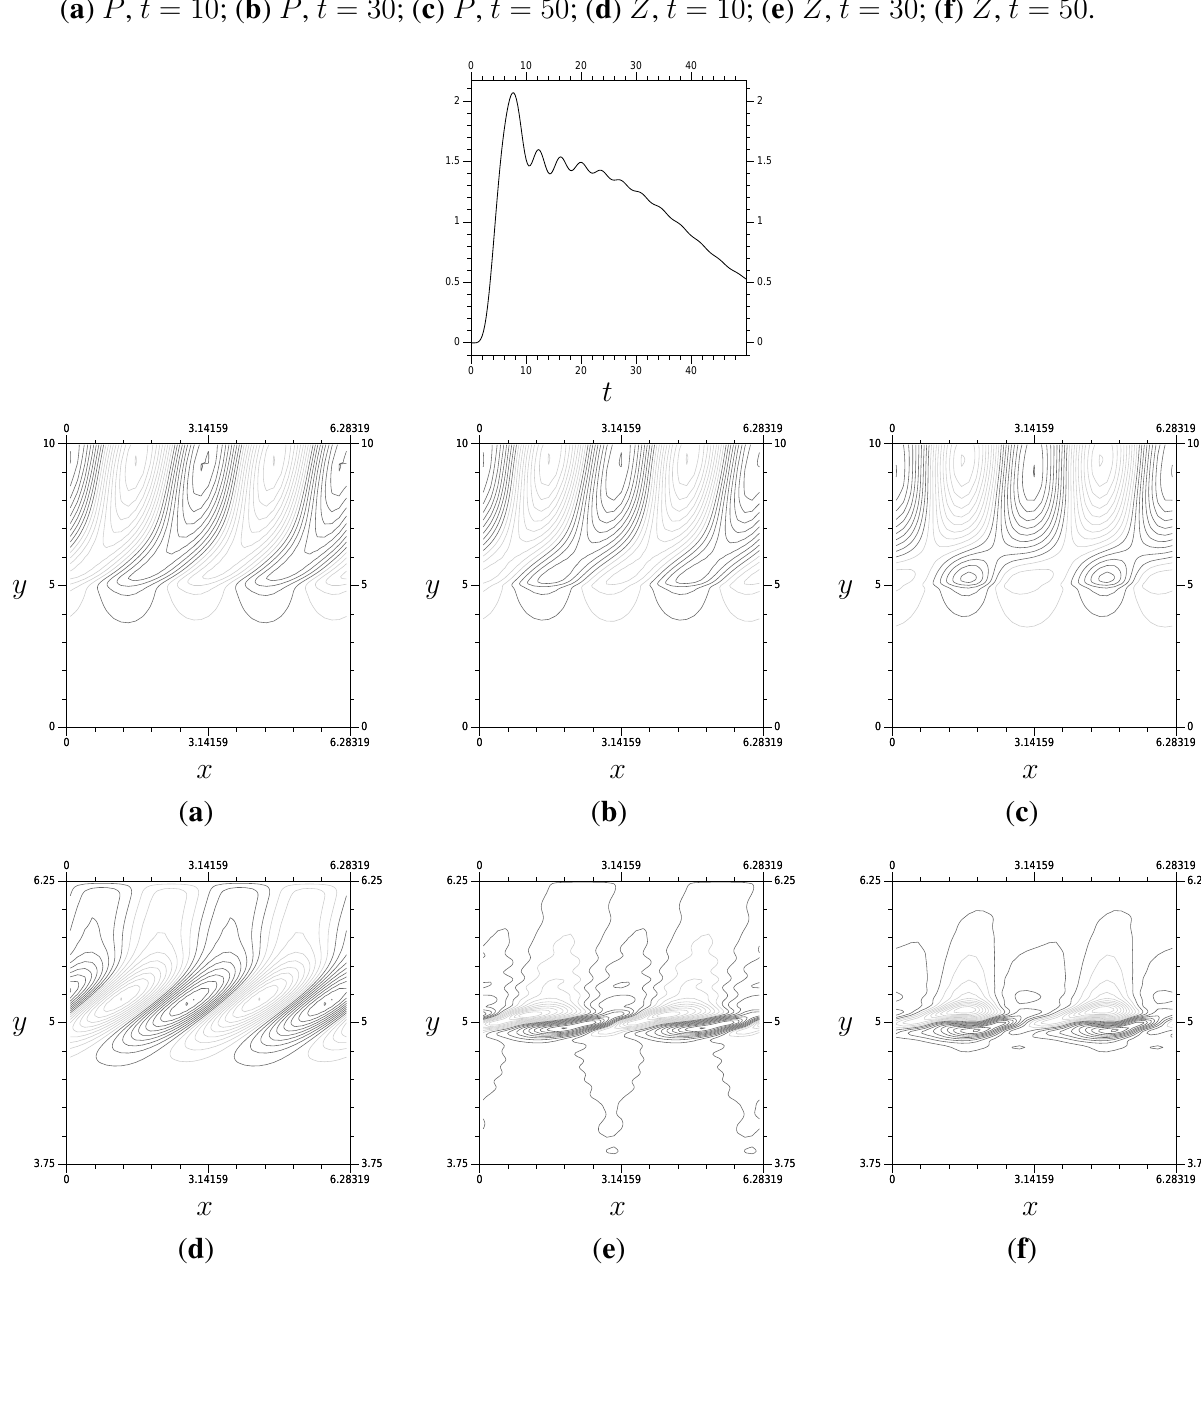
. (Top) Flux; (Middle) P ; (Bottom) Z 4